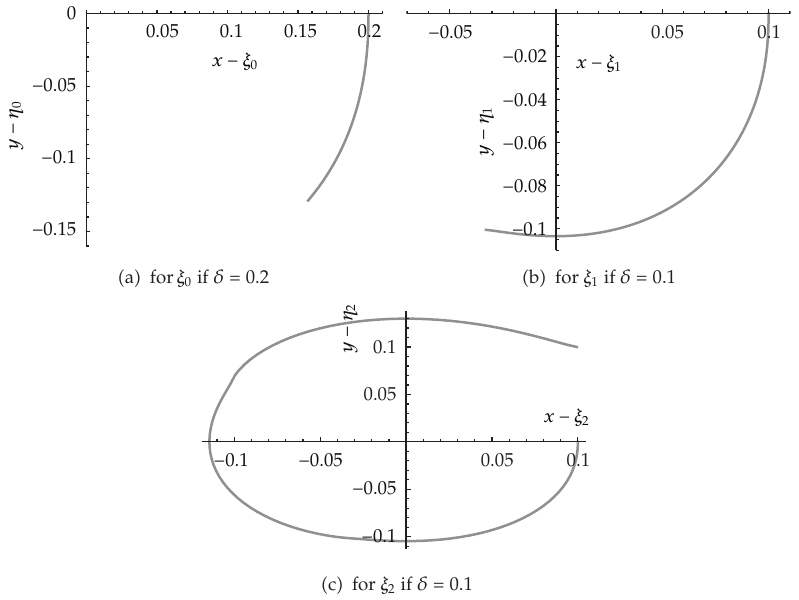
Figure 2: Phase portraits of the di ff erences between solution ξ i (cid:3) i (cid:6) 0 , 1 , 2 (cid:4) of (cid:3) 4.25 (cid:4) and respective neighboring solution in the interval t ∈ (cid:8) 0 , 1 (cid:9)